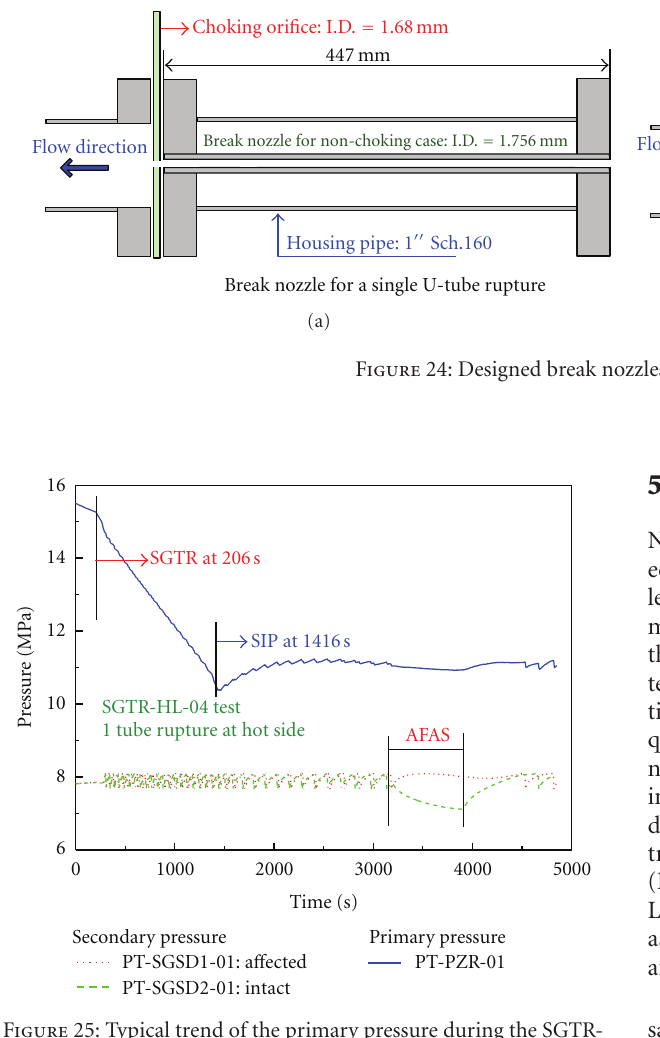
Figure 25: Typical trend of the primary pressure during the SGTR- HL-04